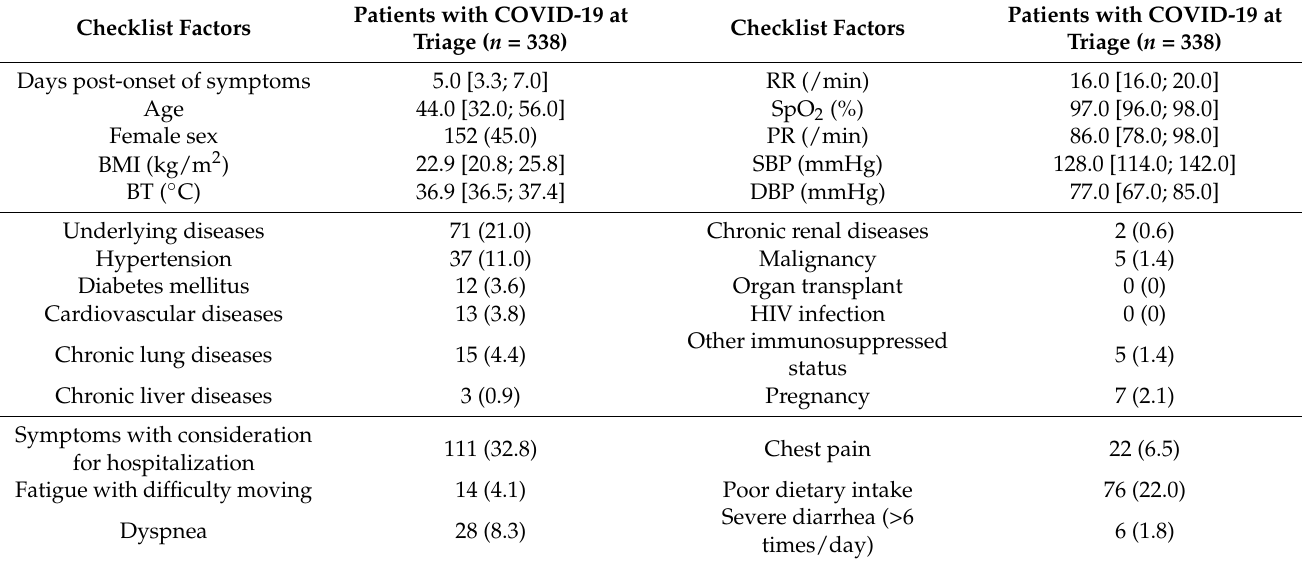
Table 1. Characteristics of patients with COVID-19 and the checklist factors at outpatient